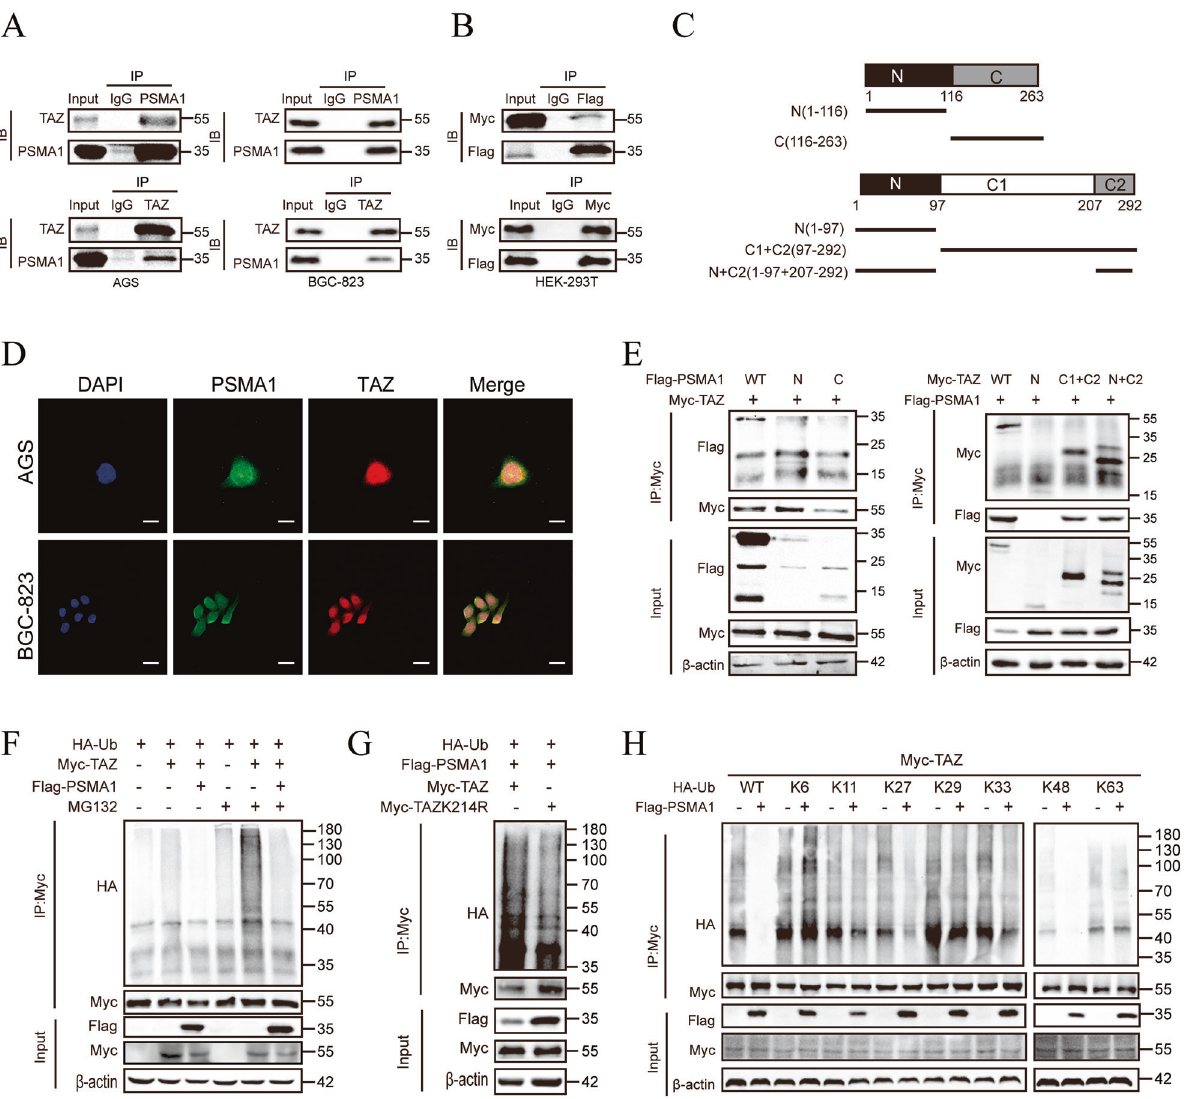
Fig. 5 PSMA1 interacting with TAZ via deubiquitination. A Endogenous PSMA1 proteins were immunoprecipitated with an anti-PSMA1 antibody and then analyzed by immunoblotting. Endogenous TAZ proteins were immunoprecipitated with anti-TAZ antibodies and then analyzed by immunoblotting. The IgG antibody was used as the control B HEK-293T cells co-transfected with Flag-PSMA1 and Myc-TAZ plasmid were subject to immunoprecipitation with anti-Flag and anti-Myc antibodies. C Segment plasmid of PSMA1 and TAZ. D Immuno fl uorescence assays for PSMA1 and TAZ in GC cells were performed to detect co-location. Bar length: 20 μ m. E HEK-293T cells were transfected with Myc-TAZ and Flag-PSMA1 or several PSMA1 deletion mutants. HEK-293T cells were transfected with Flag-PSMA1 and Myc-TAZ or several TAZ deletion mutants. A coimmunoprecipitation assay was performed to detect the interaction between PSMA1 and TAZ protein. F HEK-293T cells were co-transfected with HA-Ub, Myc-TAZ, and Flag-PSMA1 plasmid. After 48 h, the cells were treated with 20 μ M MG132 for 6 h. Representative WB analyses of ubiquitinated TAZ with or without PSMA1 overexpression. G Representative WB analysis showing the in fl uence of mutation of TAZ on PSMA1 ubiquitin. H HEK-293T cells were co-transfected HA-WT, K6, K11, K27, K29, K33, K48, or K63 Ub with Myc-TAZ and Flag-PSMA1 plasmid. Cell lysates were subjected to ubiquitination assay and the ubiquitination level of TAZ was detected by HA